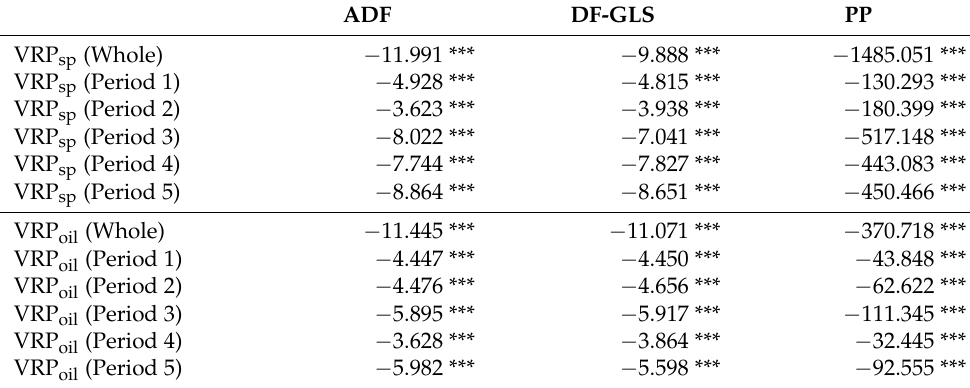
Table 3. Unit root tests of VRP sp and VRP oil